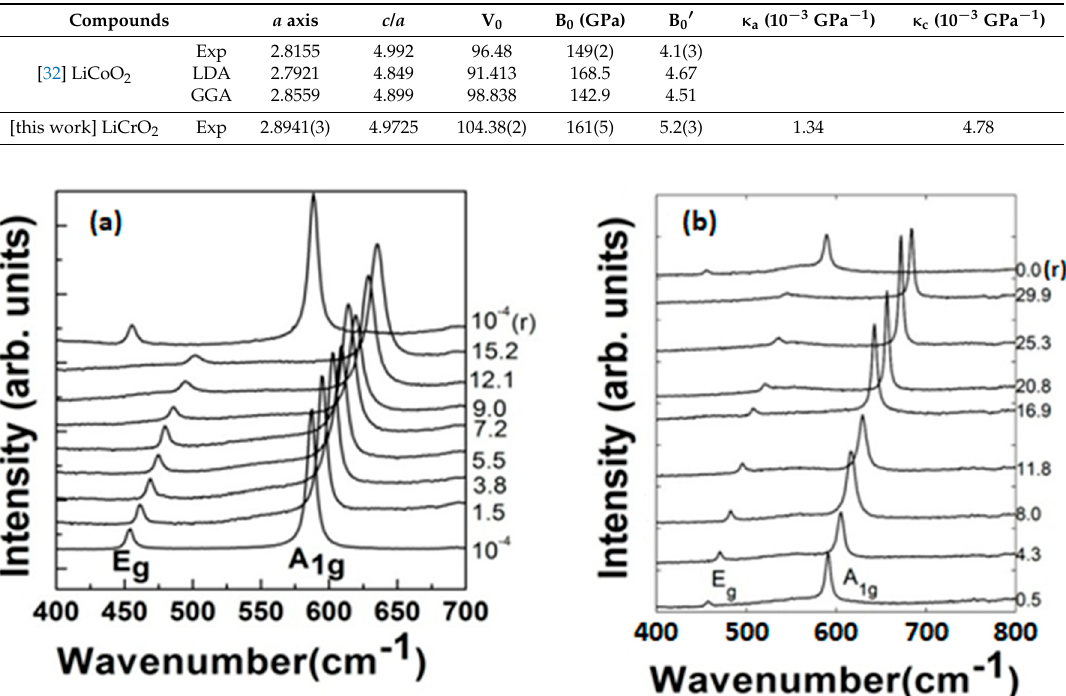
Table 3. Compressibility data of AB O 2 type family of compounds with ordered rock salt structure. LDA and GGA correspond to calculations performed within these approximations. Exp. corresponds to experiments.